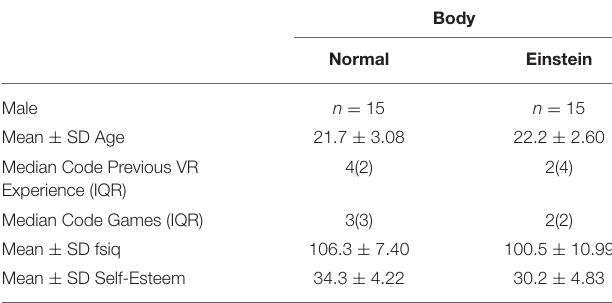
TABLE 1 | Experimental design and distribution of participants by